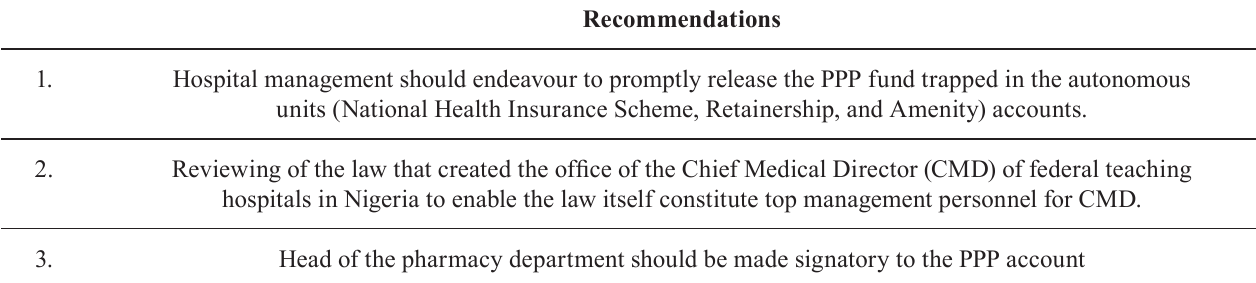
TABLE V – P articipants recommendations for the PPP model sustainability during